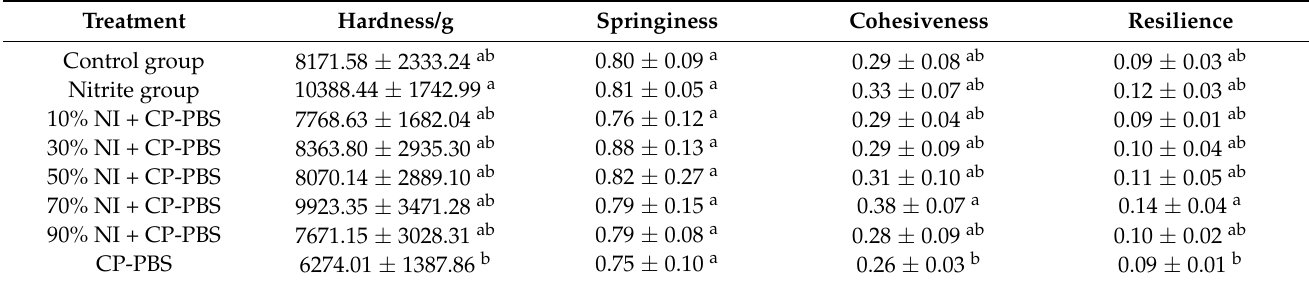
Table 4. Effect of different treatments on the texture of smoked sausages.